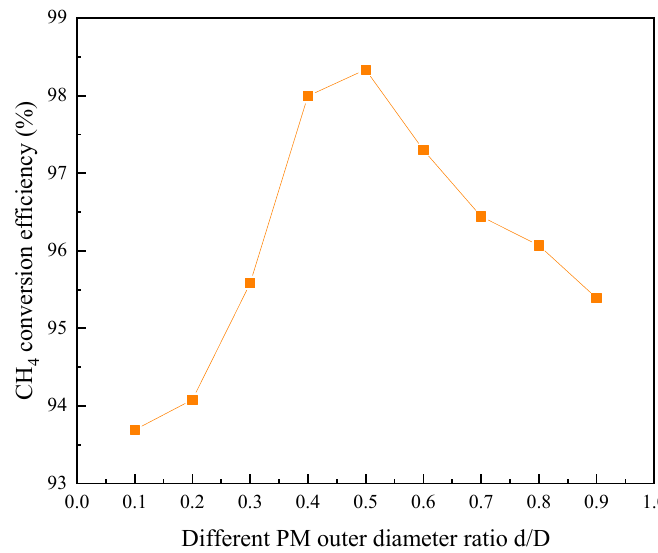
Figure 10. CH 4 conversion efficiency with different d/D porous media.